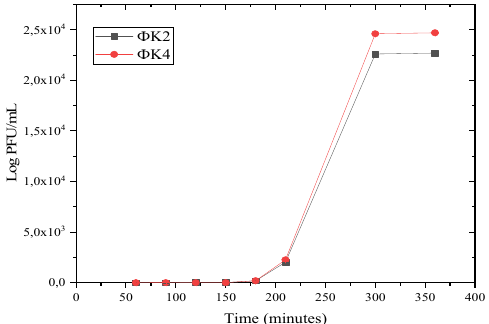
Figure 3. The rate of adsorption and the pH and thermal stability of Φ K2 and Φ K4: ( a ) thermal stability of Φ K2; ( b ) thermal stability of Φ K4; ( c ) pH stability of Φ K2 and Φ K4; ( d ) adsorption of Φ K2 and Φ K4 to the A. tumefaciens AGL1 WT host. The black arrow indicates the optimal adsorption value. Results are presented as mean values ± SD.